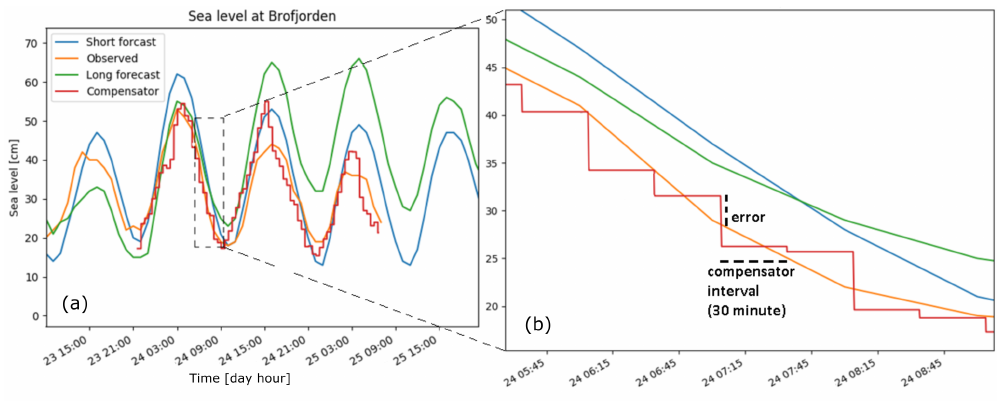
Figure 13. ( a ) Experimental results from a positioning test of the chain in October 2018. ( b ) Zoom out of the area marked by the dotted rectangle in